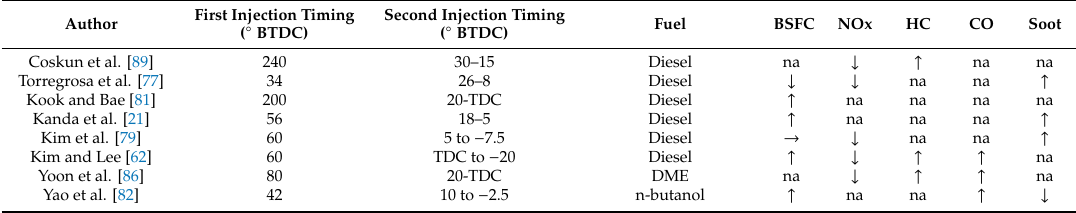
Table 5. Variation of performance and emissions after retarding the second injection timing